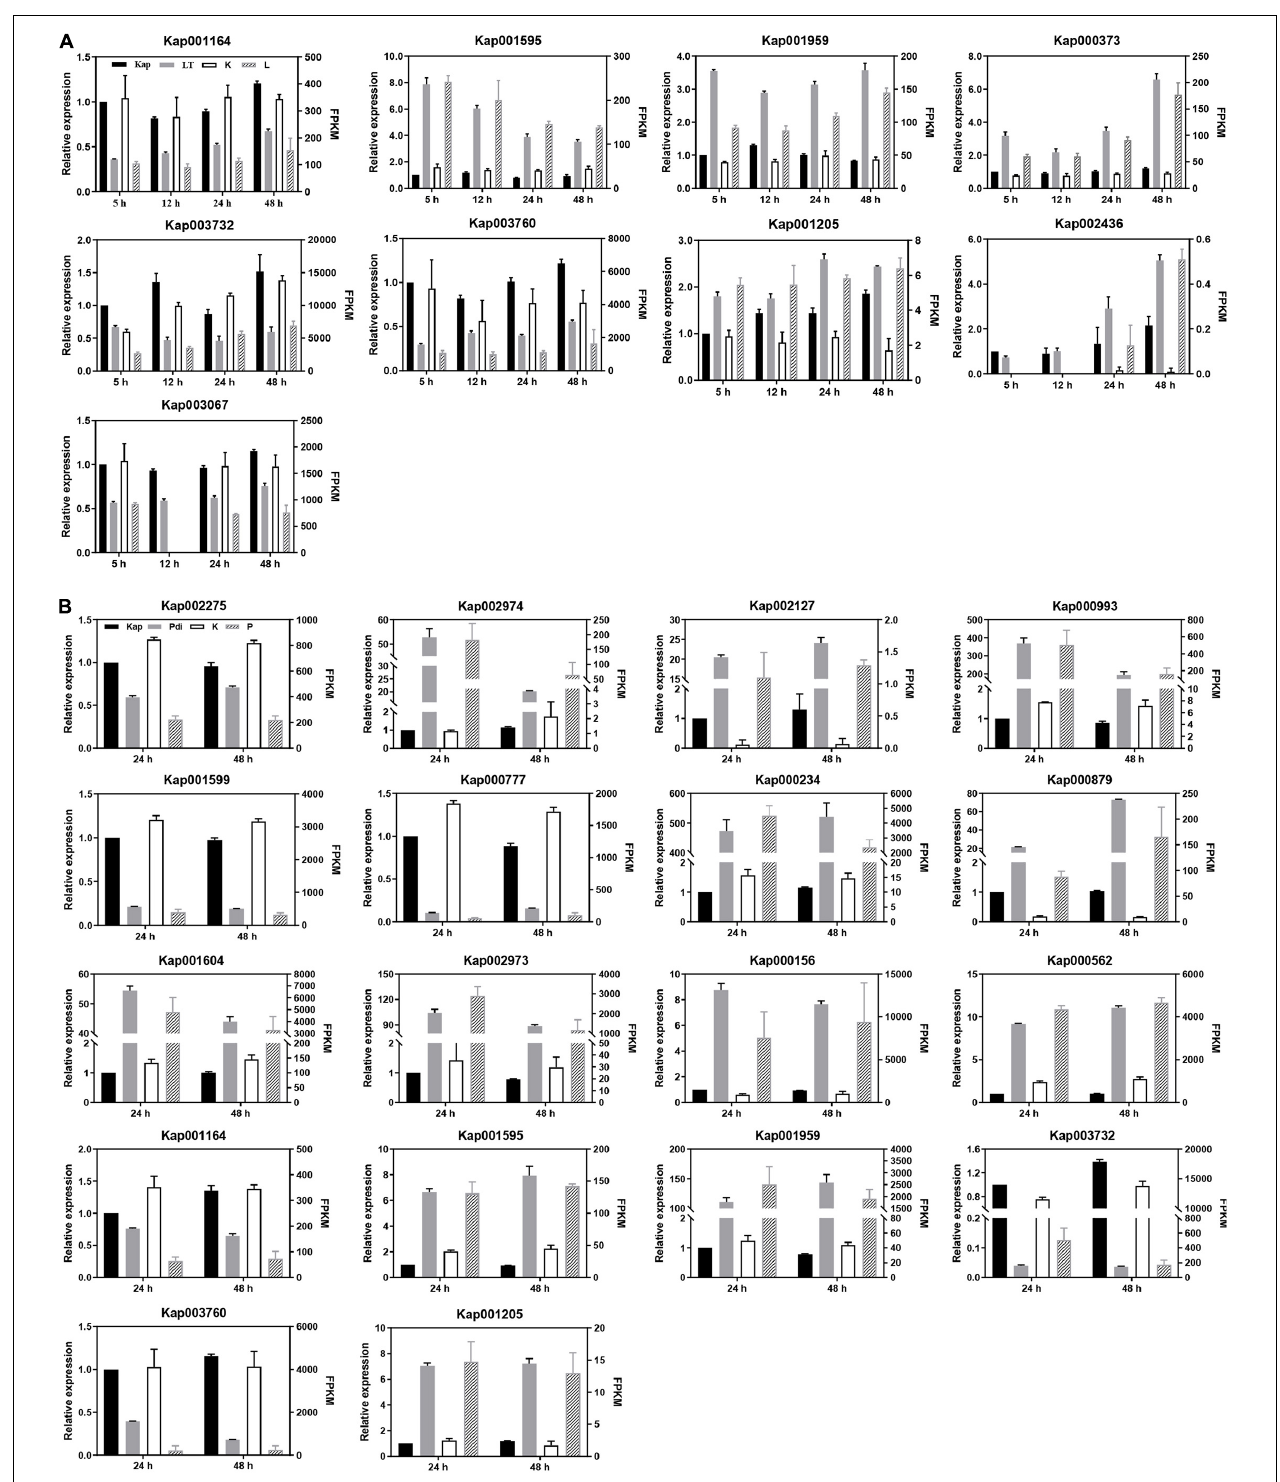
FIGURE 3 | qRT-PCR analyses of DEGs. (A) Low temperature treatment. (B) Co-incubation with P. digitatum treatment. “Kap,” “LT,” and “Pdi” are the qRT-PCR results (left Y -axis) of differentially expressed genes, respectively. “K,” “L,” and “P” are the transcription expression abundance (FPKM, right Y -axis) of the differentially expressed genes in the RNA-seq results,